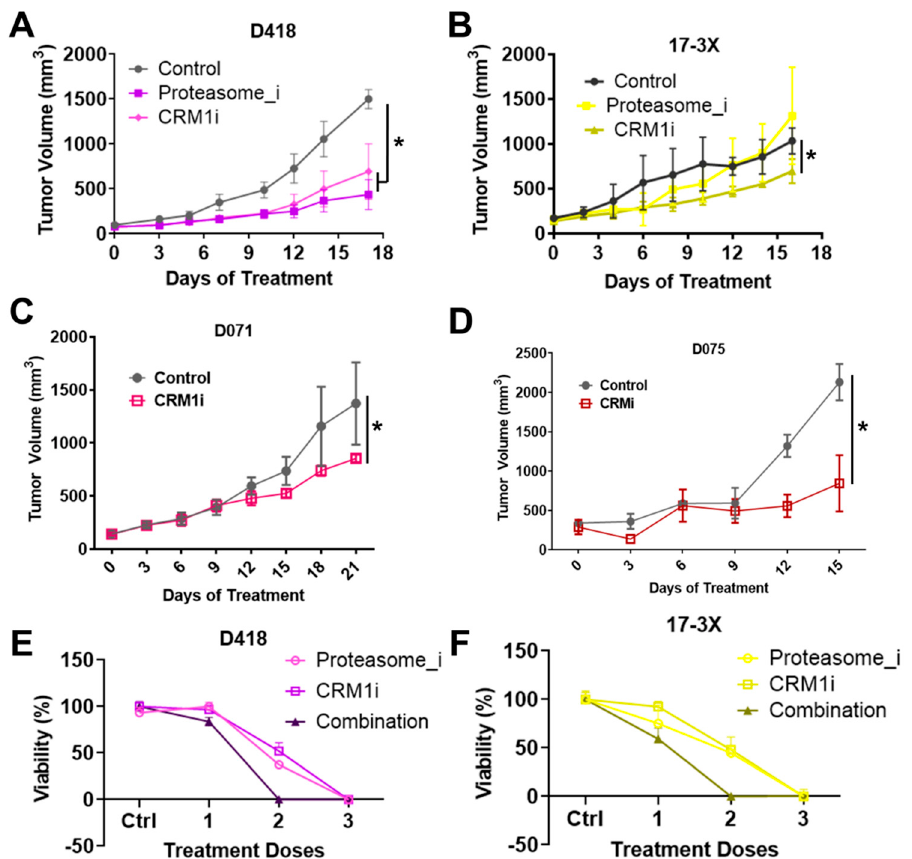
Figure 5. Proteasome and CRM1 nuclear export pathway inhibition reduces osteosarcoma tumor growth and induces synergistic killing of osteosarcomas. ( A ) CRM1 inhibition (verdinexor), but not proteasome inhibition (bortezomib) significantly reduced tumor growth in 17-3X. ( B ) Both CRM1 and proteasome inhibition significantly reduced D418 tumor growth. ( C , D ) CRM1 inhibition significantly reduced tumor growth rate of D071 and D075 patient-derived xenografts in vitro. ( E ) Combined CRM1 and proteasome inhibition led to synergistic inhibition of 17-3X and ( F ) D418 cell growth. * ( p <